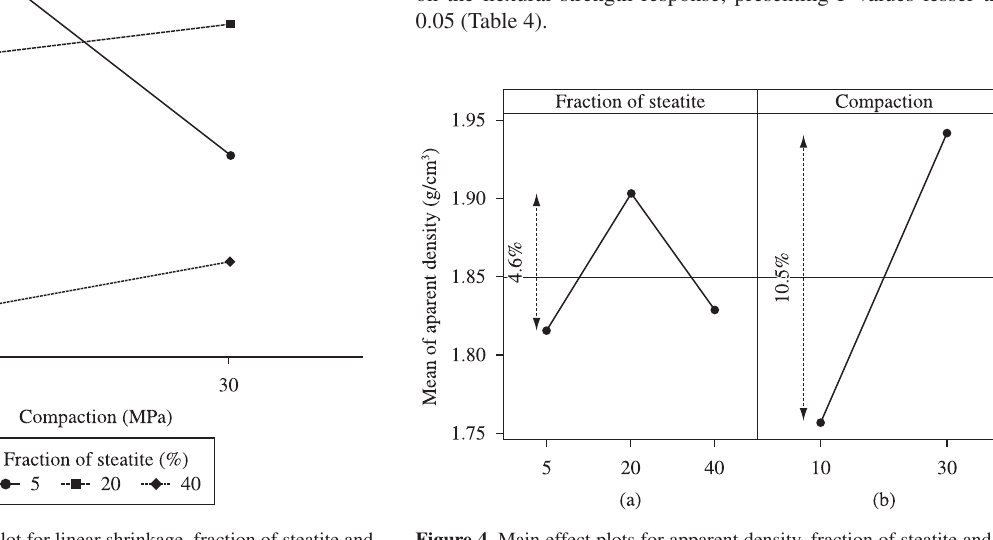
Figure 4. Main effect plots for apparent density, fraction of steatite and the compaction.